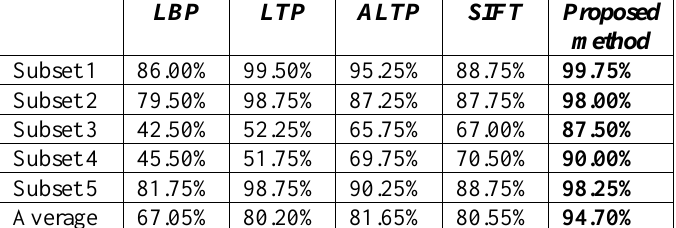
Table 5. Recognition accuracy ratio of different methods on the FERET database.